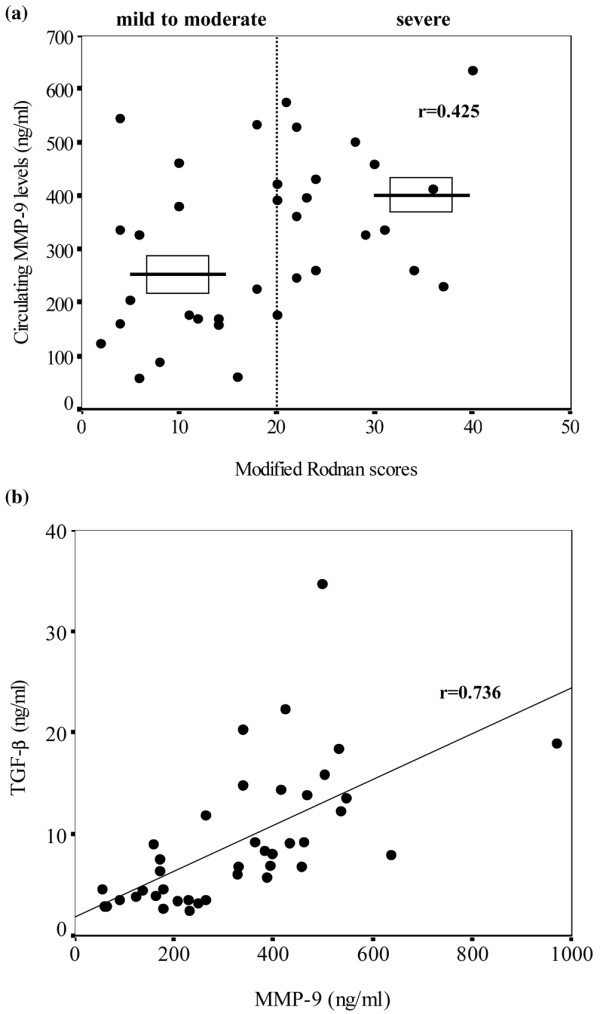
Correlation of circulating matrix metalloproteinase-9 (MMP-9) concentrations with skin fibrosis and with concentrations of transforming growth factor β (TGFβ). (a) Correlation of MMP-9 concentrations with skin scores. The extent of skin involvement of systemic sclerosis was determined by modified Rodnan scores. Broken line indicates cutoff value for patients with severe skin involvement (Rodnan score ≥20). Bars represent the mean ± standard error of the mean of MMP-9 in patients with severe versus mild-to-moderate skin involvement (Rodnan score <20). (b) Correlation of circulatory MMP-9 concentrations with TGFβ concentrations.